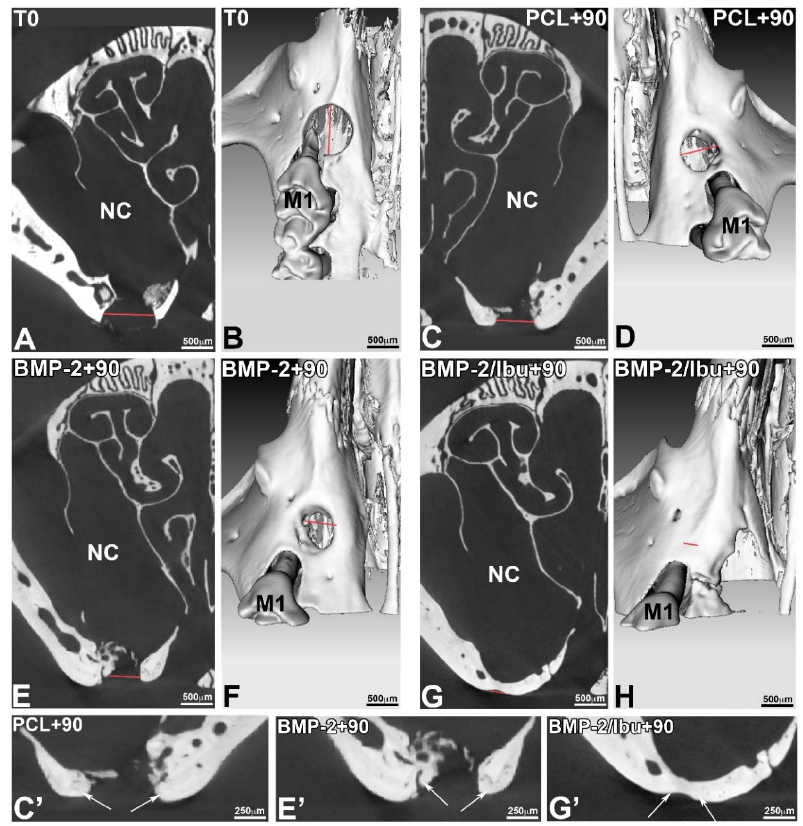
Figure 5. Micro ‐ CT sections ( A , C , E , G , C’ , E’ , G’ ) and 3D reconstructions ( B , D , F , H ) at T0 ( A , B ) and after 90 days of implantation of PCL ( C , D , C’ ), PCL/BMP ‐ 2 ( E , F , E’ ), and PCL/BMP ‐ 2/Ibu ( G , H , G’ ). To